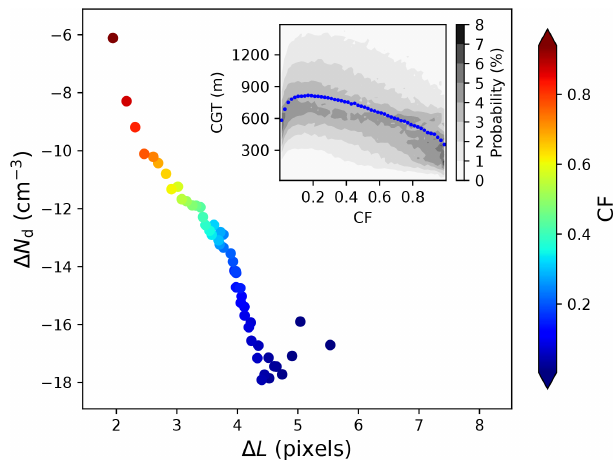
Figure 6. Relationships between (cid:49)L and (cid:49)N d , with the data grouped as a function of CF and each CF bin containing the same number of samples. A joint histogram between CF and CGT is shown in the inner plot; the blue dot shows the median CGT at each CF